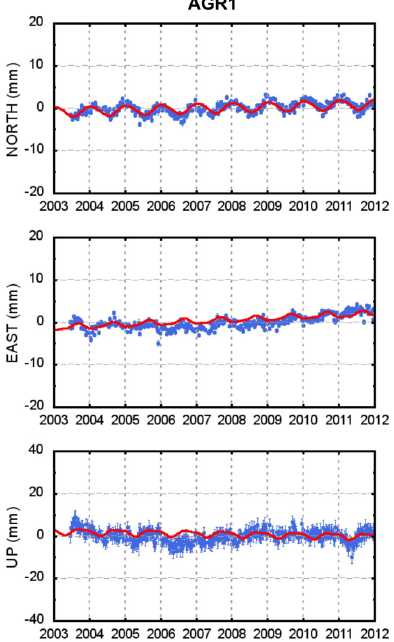
Figure 2. Weekly position time series of AGR1 GPS station. North and east components are relative to ENAV station. Red line repre- sents the sum of linear trend, annual and semi-annual periodic sig- nals estimated with the CATS